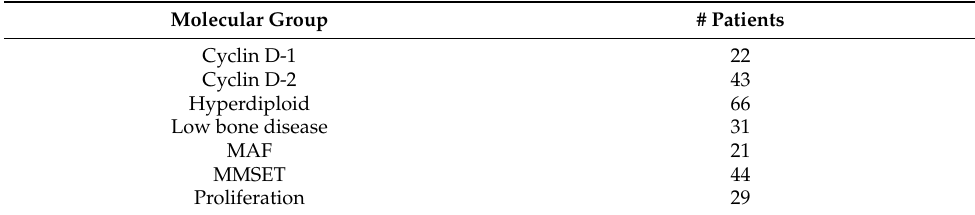
Table 7. Multiple Myeloma Data: IMWG molecular cytogenetic classification.